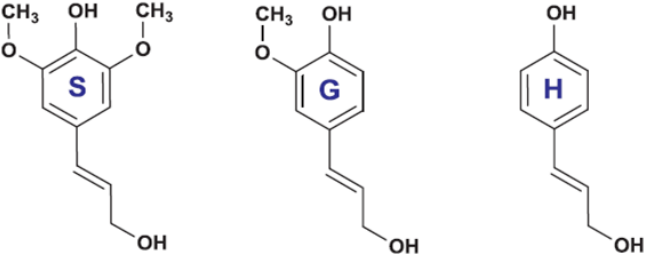
Figure 1. Chemical structures of different lignin monomers: sinapyl alcohol (S), coniferyl alcohol (G), and p-coumaryl alcohol (H) (Adapted with the permission from Ref [3]. Copyright © 2019 Else- vier Ltd.).